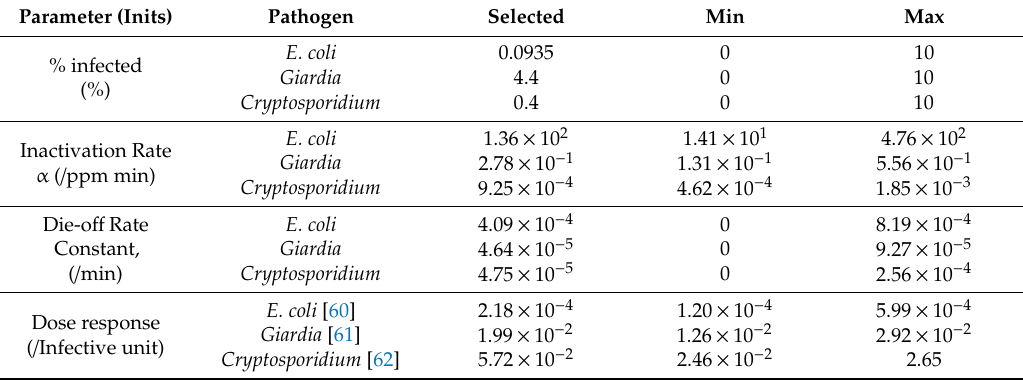
Table 5. Selected, minimum, and maximum values used in the sensitivity analysis for E. coli , Giardia , and Cryptosporidium a